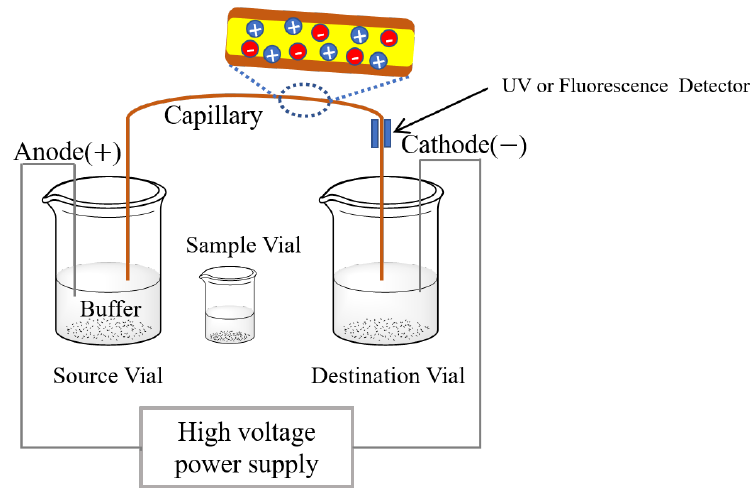
Figure 3. Mechanism of detecting lactoferrin by capillary electrophoresis (CE).